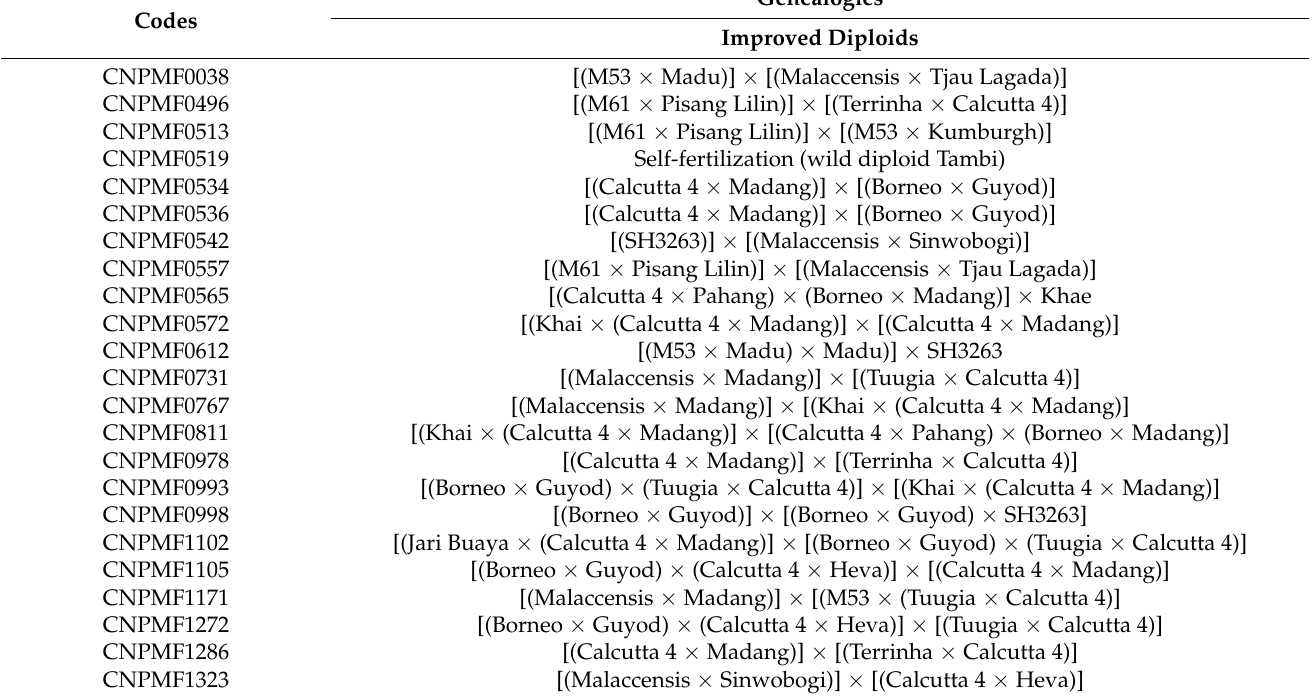
Table 1. Banana hybrids evaluated for resistance to Pseudocercospora fijiensis in a naturally infested area in Brazil, Embrapa 2021.